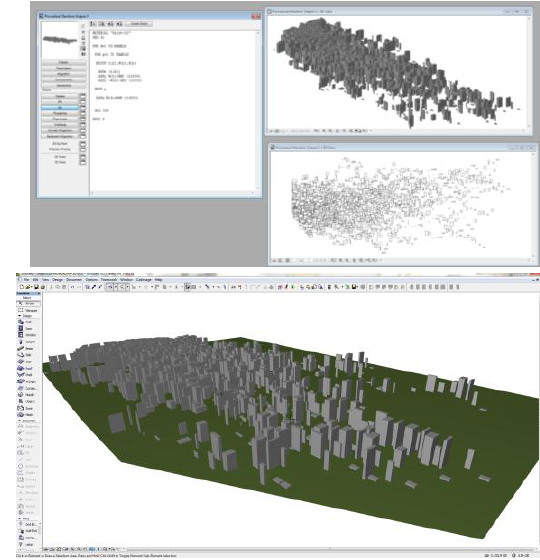
Figure 10. Automatically generated 3D content with GDL using random parameters and transformations.